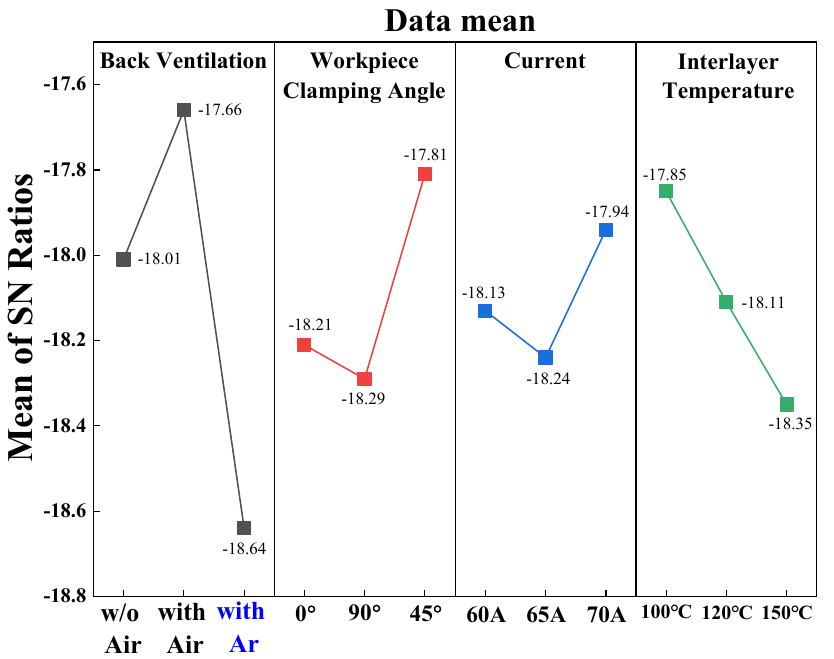
Figure 4. S / N ratio factor response graph of α -Fe content of UNS31803 duplex stainless steel in L9 direct cross table.